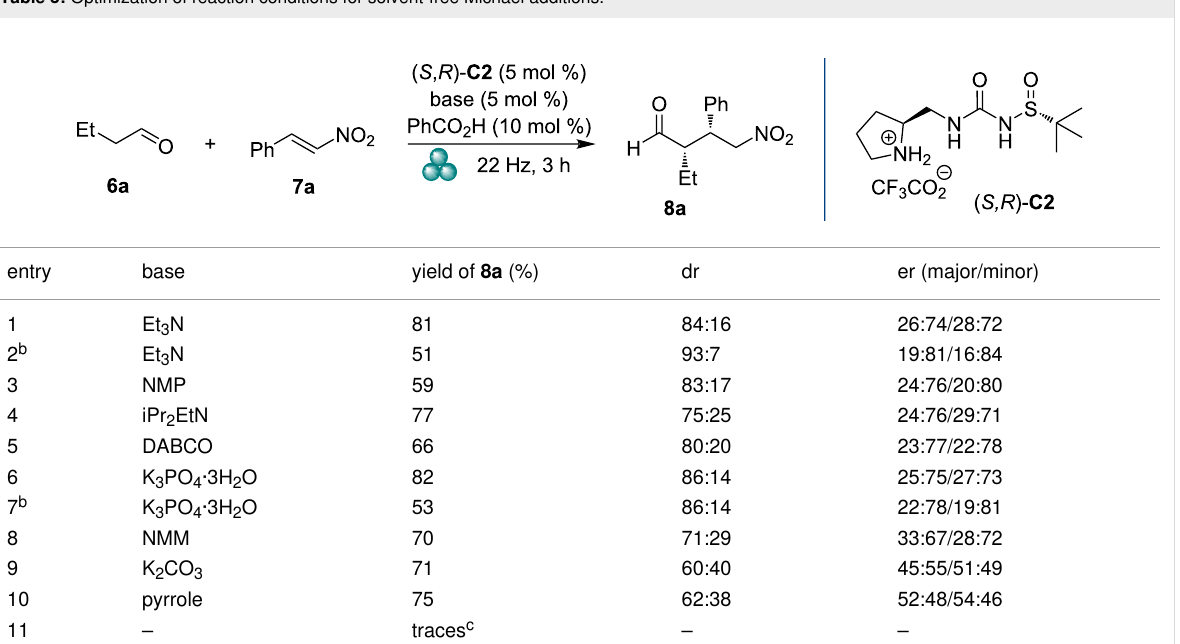
Table 3: Optimization of reaction conditions for solvent-free Michael additions.